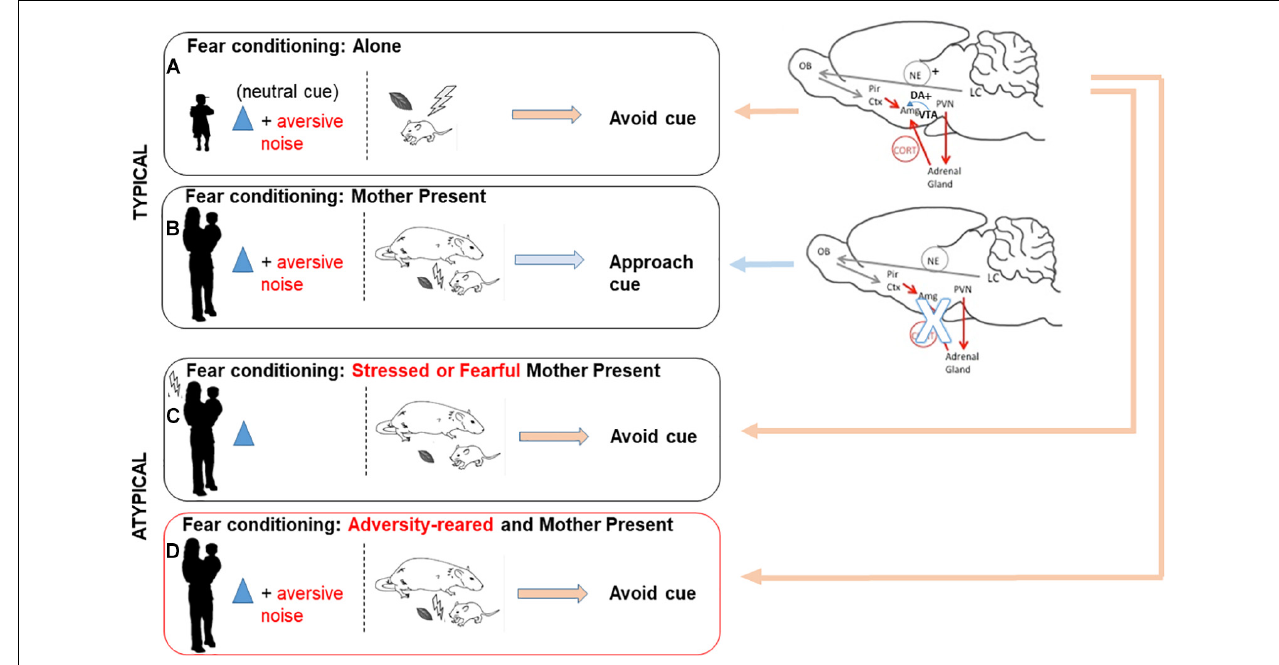
FIGURE 1 | Typical and disrupted maternal social buffering of amygdala-dependent fear. During a sensitive period across species, maternal presence is an important social cue to infants: maternal suppression of infant stress hormone levels helps guide pups’ response to stimuli as safe or threatening to influence what is learned about the world. Here we illustrate two opposing brain networks and behavioral outcomes engaged by infants in response to a threat, depending on maternal presence and context. (A) When young are exposed to a neutral cue paired with an aversive cue, amygdala engagement promotes future avoidance of the neutral cue. (B) Maternal presence during a sensitive period suppresses the circuitry engaging the amygdala, including the HPA axis and dopamine from the VTA. (C) When the mother is stressed or fearful toward a neutral cue, buffering is impaired and amygdala-dependent learning is maintained. (D) Finally, maternal presence fails to buffer amygdala-dependent learning if the young has been reared in the context of adversity with a stressed or maltreating